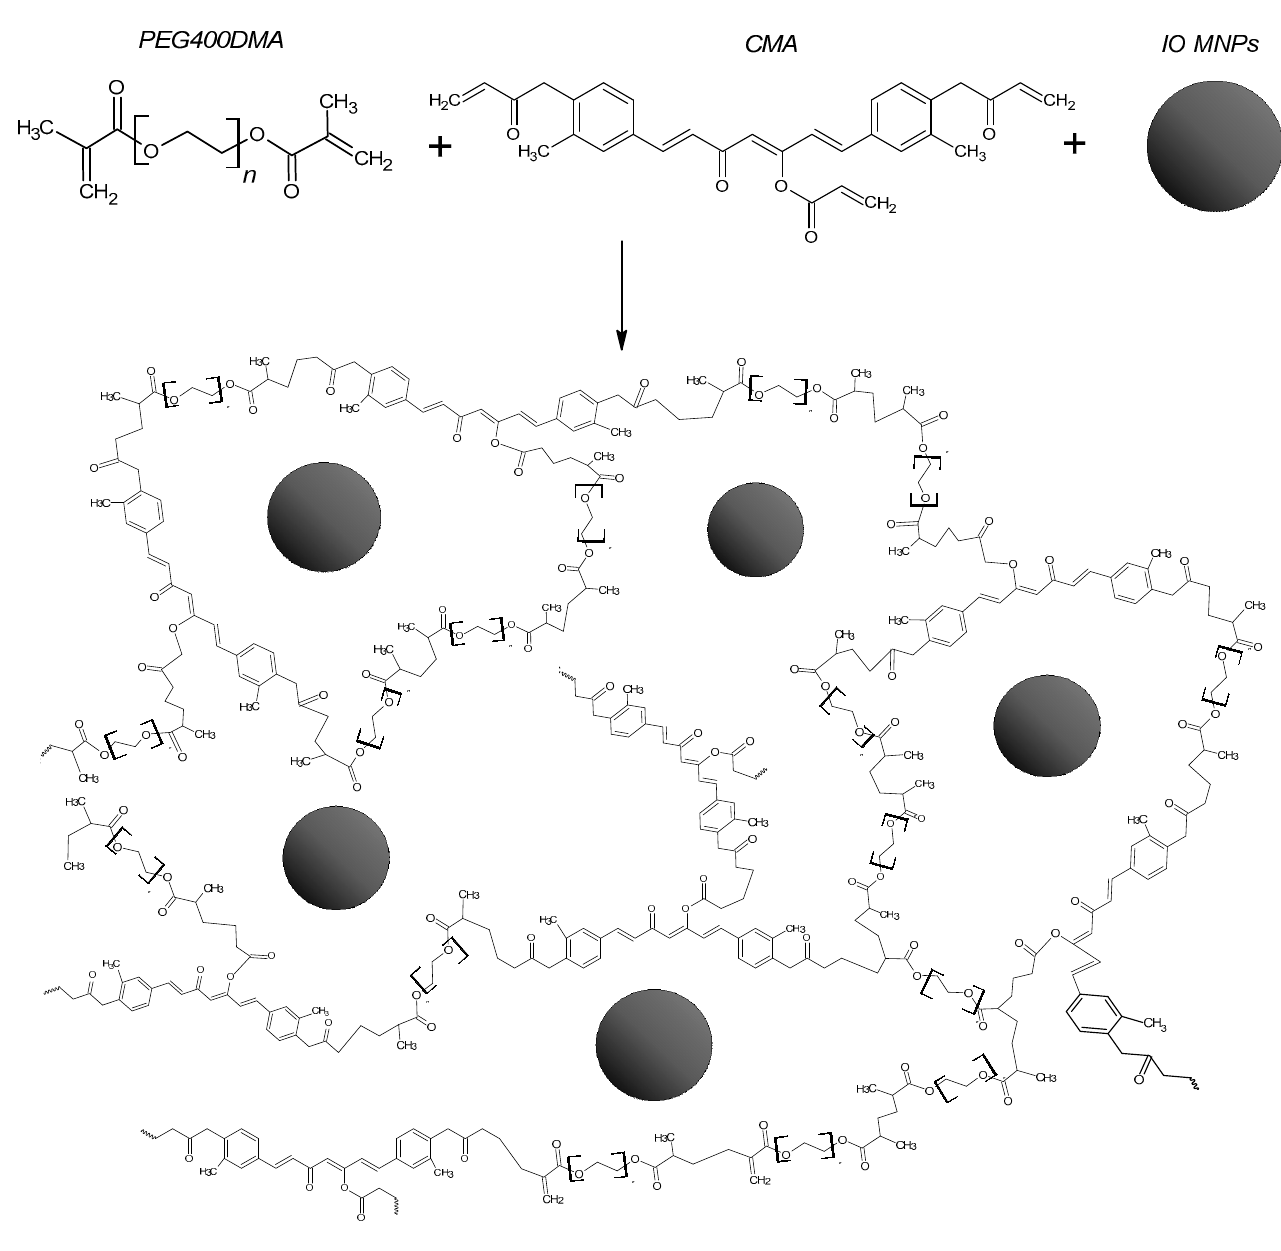
Figure 1. Schematic representation of the crosslinked polymer matrix interaction with the iron oxide magnetic nanoparticles within the magnetic nanocomposite microparticles (MNMs). Shown here are the CMA MNM gels for representation purposes. Here, the squiggly line represents the continuation of the polymer chain.